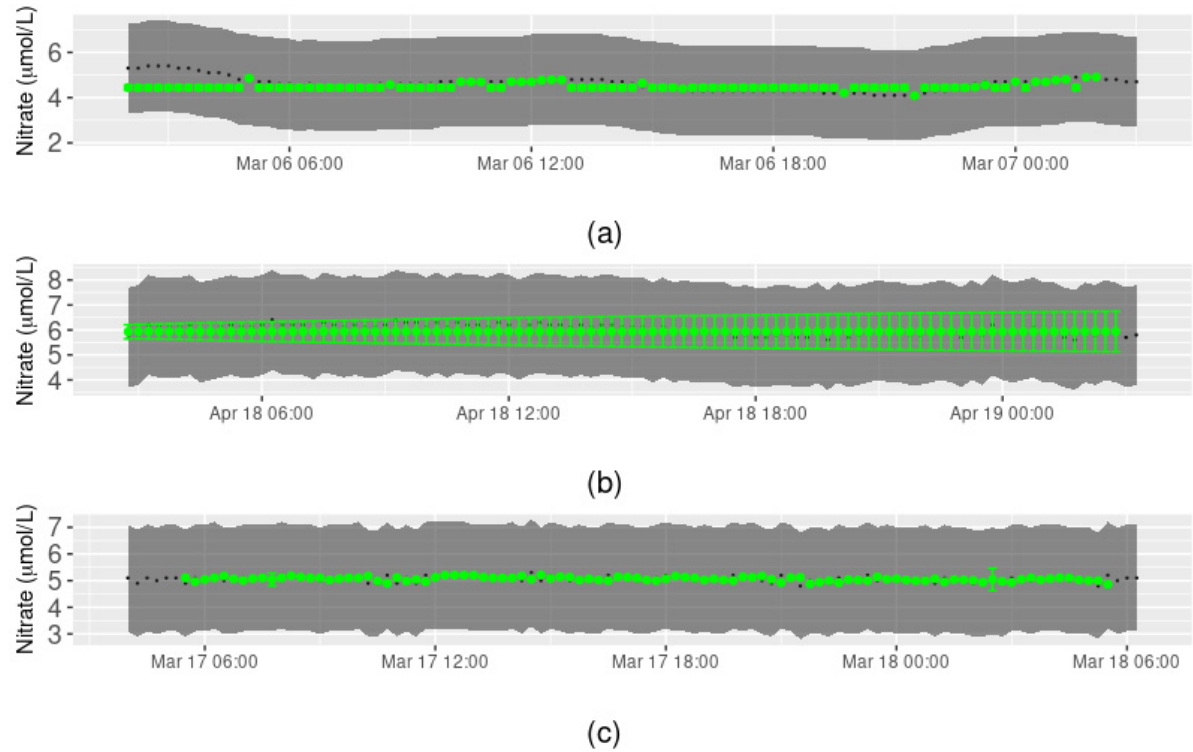
Figure 7. Performance evaluation: missing sequential data examples. Examples for different periods of randomly removed one-week sequences of observations, simulated 100 times, where data were reconstructed using ( a ) GAM and ARIMA, ( b ) ARIMA only, and ( c ) GAM only. Dark points represent the real nitrate concentration value and the shaded area around those points is the precision interval of the sensor. Green points and shading are the predicted values along with the prediction interval. Prediction intervals may not be visible when they are narrow relative to the precision interval of the sensor.